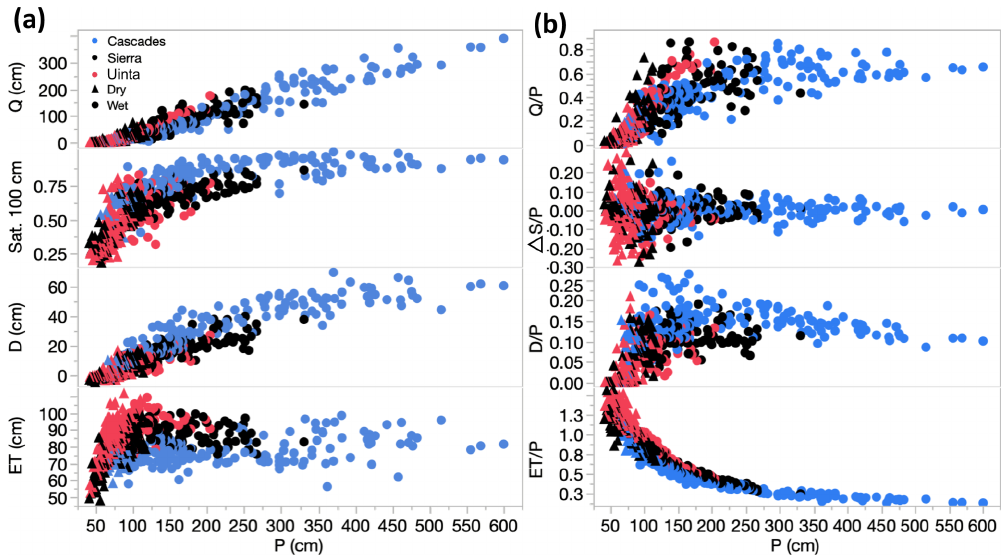
Figure 3. (a) Annual runoff ( Q ), mean saturation at 100cm depth (Sat 100 ), deep drainage ( D ), and evapotranspiration (ET) vs. annual precipitation ( P ) classified by region and climate type. (b) Q/P , (cid:49)S/P , D/P , and ET /P vs. P classified by region and climate type. Dry sites P/ PET ≤ 1, wet P/ PET > 1. Data from historical input scenarios for soil profile 1056,